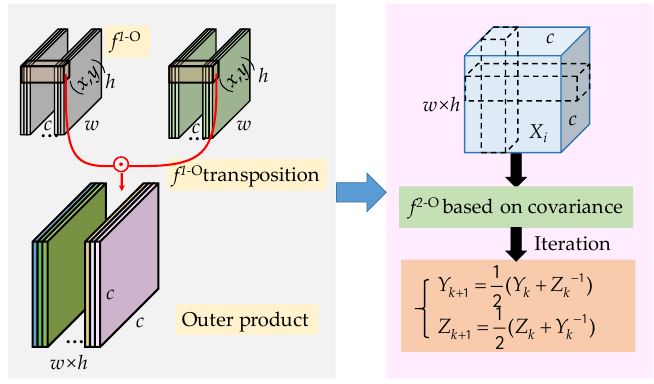
Figure 7. The generation of 2-O information based on covariance.